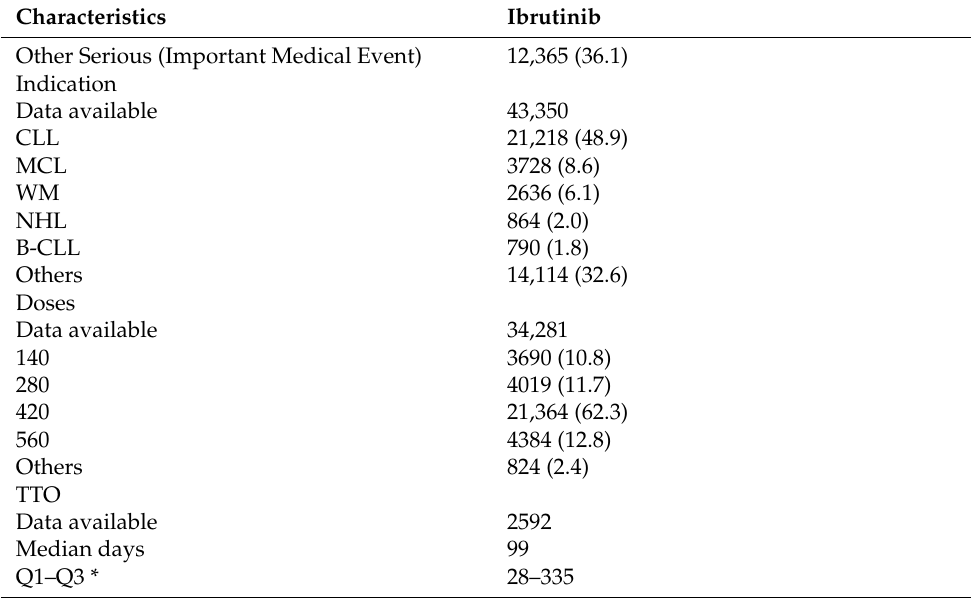
Table 2. Cardiovascular events in standardised MedDRA Query (SMQ) with disproportional- ity analysis in United States Food and Drug Administration Adverse Event Reporting